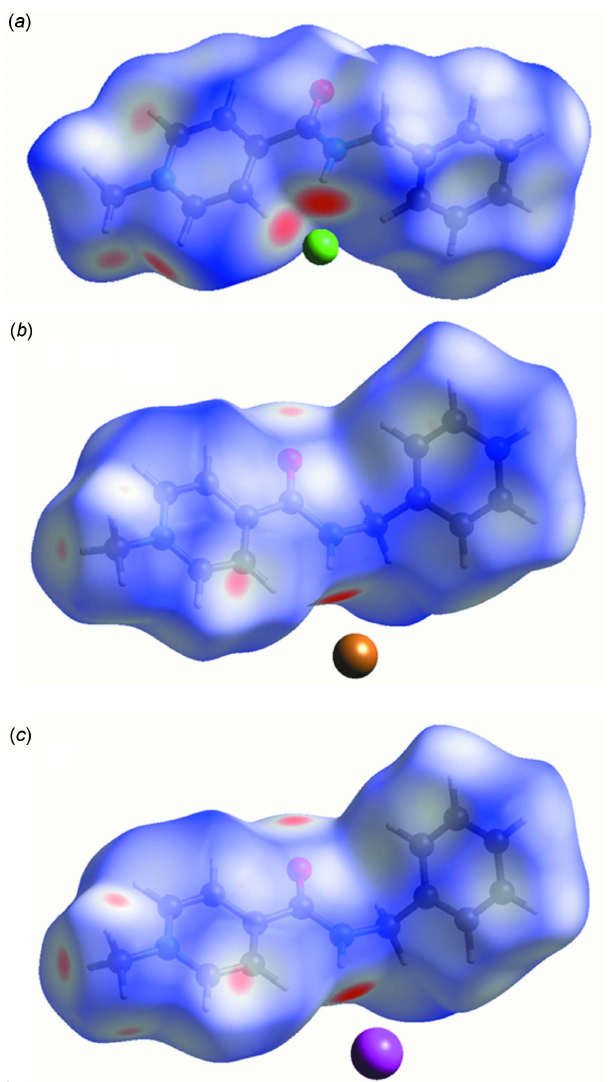
Figure 6 Contributions of the different types of interactions to the total Hirshfeld surface of the cation in three halogenide salts.